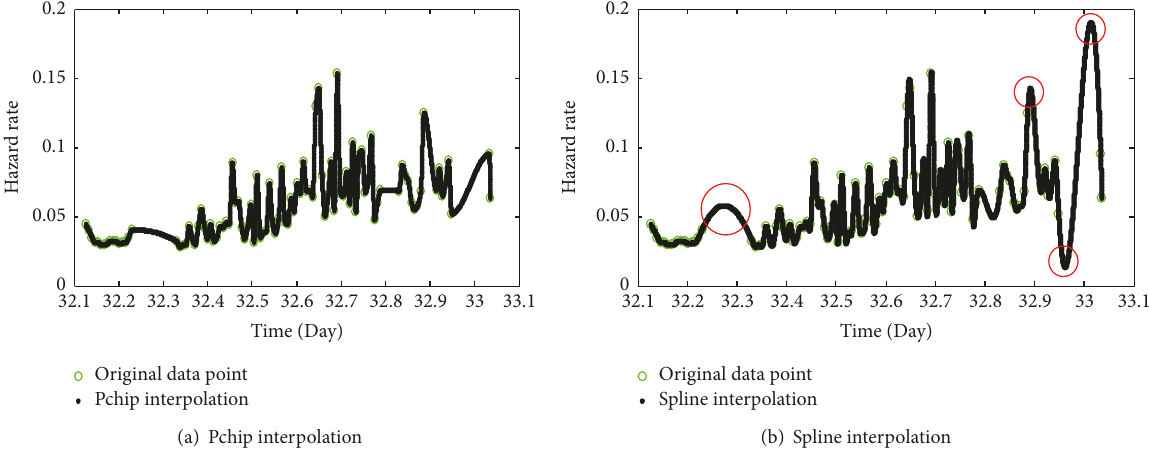
Figure 8: The comparison of interpolation results of period (c).